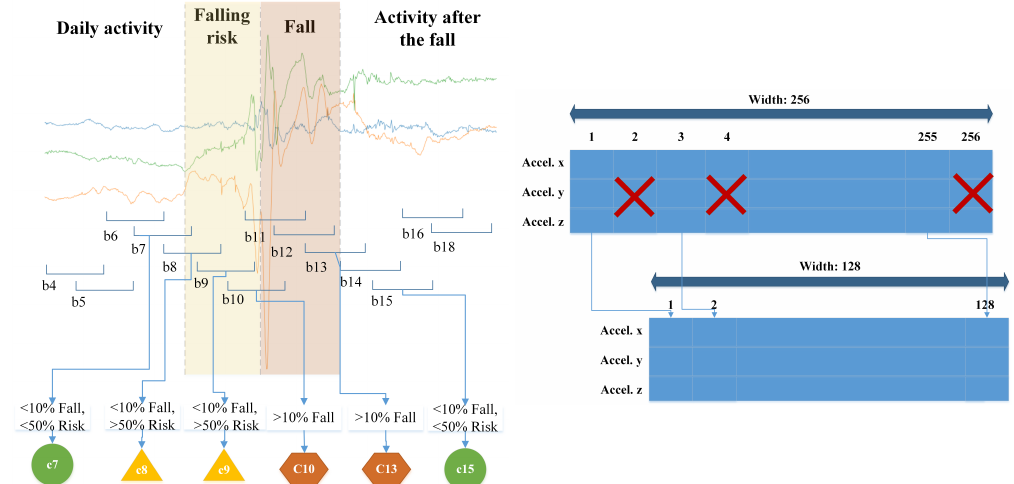
Figure 1. On the left: Recording segmentation and labeling process. Green circles, yellow triangles and red hexagons indicate the block is classified as a background (BKG), a risk of falling (ALERT) or a fall event (FALL), respectively. On the right: Block width reduction process. In the case illustrated, a 256-width block, corresponding to a frequency sampling of 200 Hz, is reduced to 128 samples to obtain a frequency sampling of 100 Hz. The same process was performed with 128-width and 64-width blocks to obtain 64-width (50 Hz) and 32-width (25 Hz) datasets, respectively.